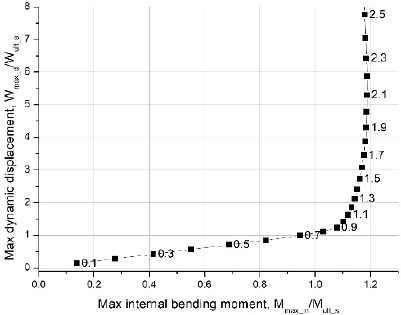
Figure 14. Internal bending moment and vertical displacement for mid-span box girder M1 at load